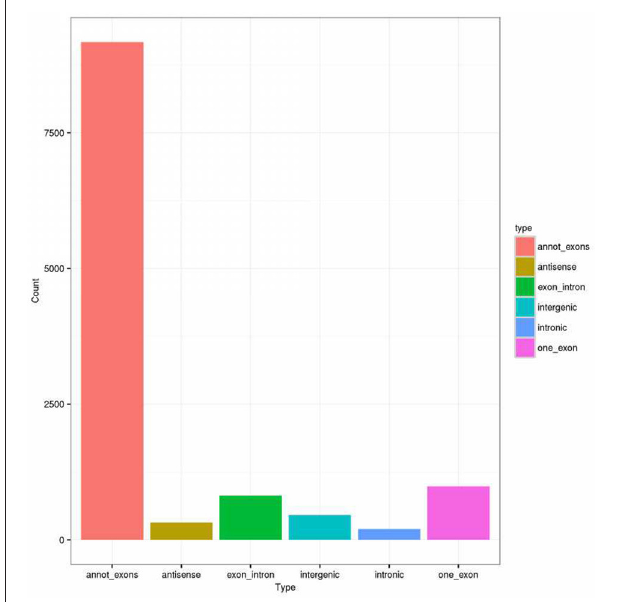
FIGURE 3 | The bar diagram shows the circRNA category. Most of differentially expressed circRNAs originate from the exons. Some are from introns, while, a few are other sources.